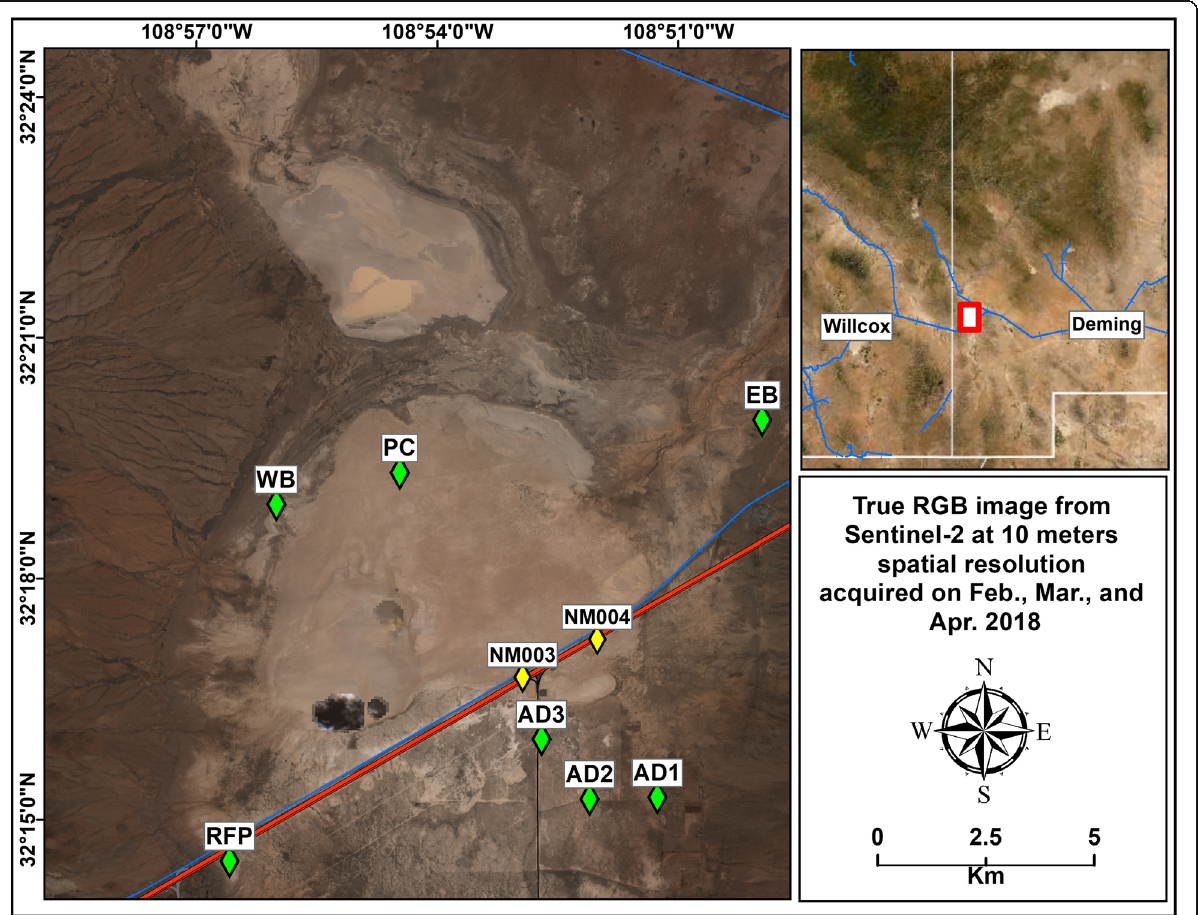
Fig. 1 Satellite image of Lordsburg Playa dissected by Interstate 10 showing the locations (green diamonds) of surfaces that were tested with the PI-SWERL as listed in Table 1 and the NMDOT weather stations (NM003 and NM004) (yellow